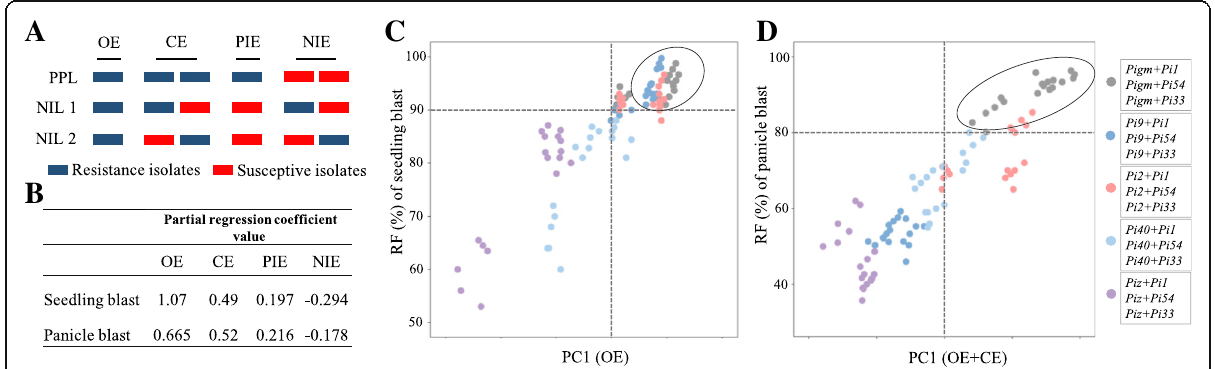
Fig. 3 Different interaction effects in PPLs and their relationship with seedling blast and panicle blast RF of PPLs. a Four interaction effects produced in PPLs, b Correlation between interaction effects and RF of PPLs. β is the partial regression coefficient value of the linear regression, c Principal component analysis of OE with seedling blast RF of PPLs, d Principal component analysis of OE + CE with panicle blast RF of